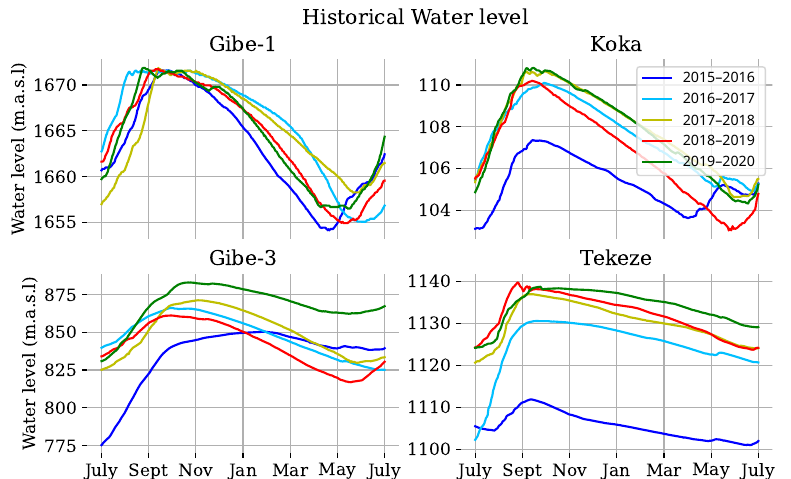
Figure 2. Historical pattern of water levels for Gibe 1, Gibe 3, Koka, and Tekezé reservoirs; source: